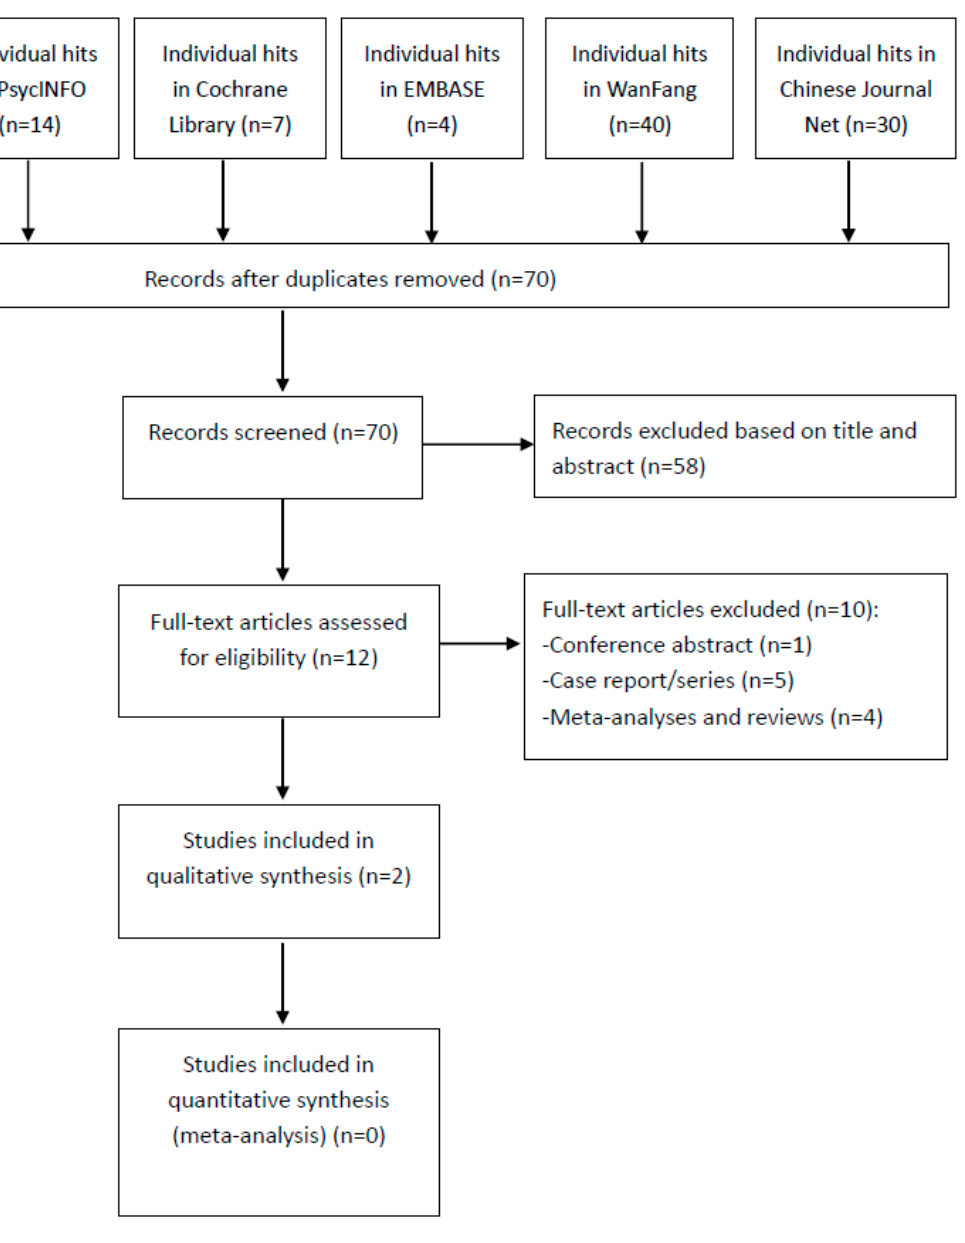
Figure 1. PRISMA flow diagram.